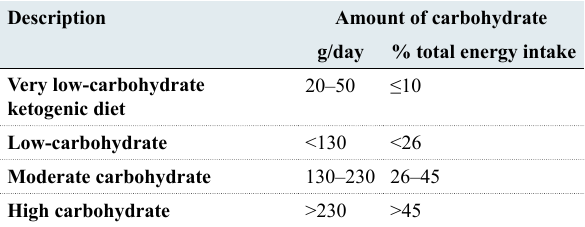
Table 1: Classification of diet according to the amount of carbohydrates